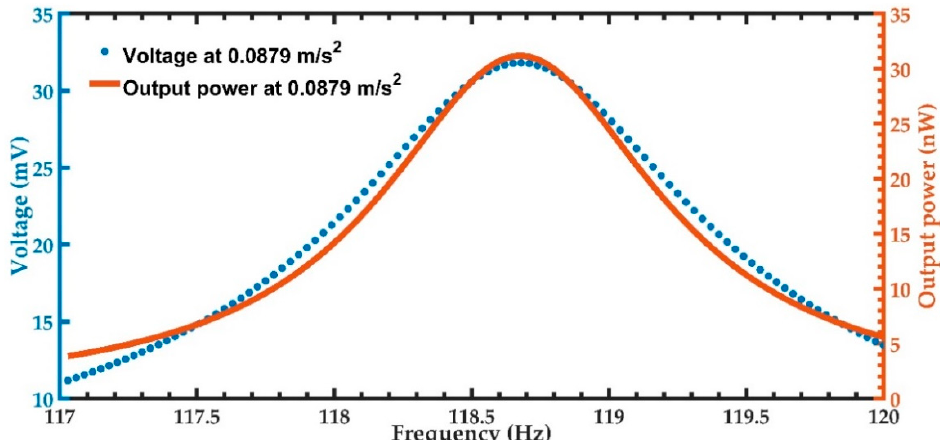
Figure 9. Static deflection of the piezoelectric nanogenerator obtained using the analytical and FEM models.